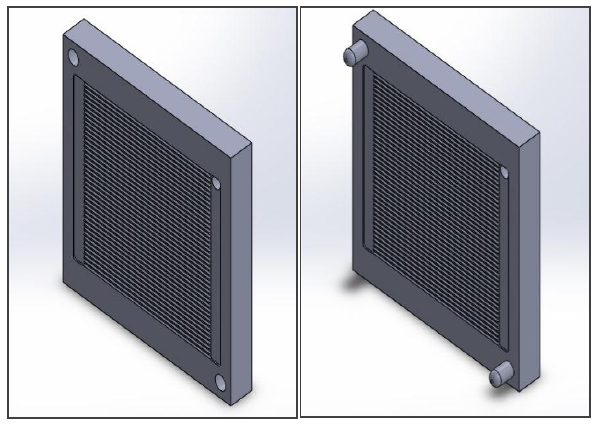
Fig. 1. Perspective of the fabricated micro-channel